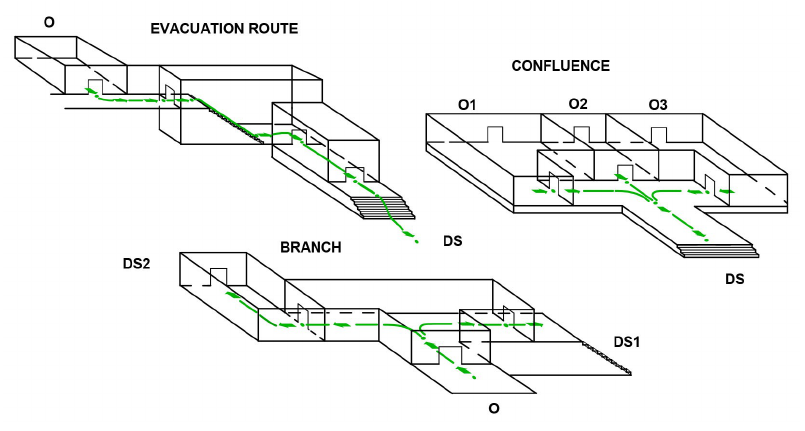
Figure 1. Evacuation route, confluence, and